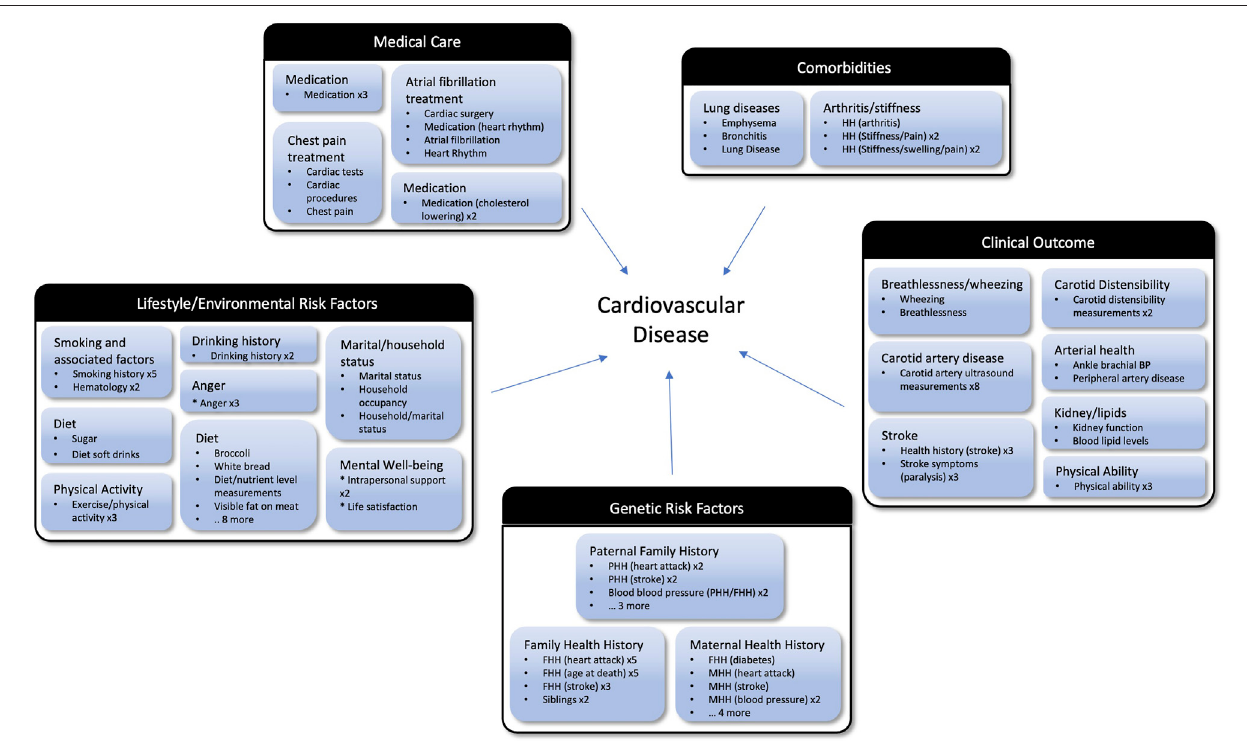
FIGURE 6 | Cluster groups organized into topics based on the goals of the ARIC study. The outer black and white boxes are topics (e.g., Clinical Outcome and Medical Care) and each topic contains multiple cluster groups (e.g., Stroke and Lung Diseases) which are the blue boxes. Listed under the manually assigned label for each cluster groups are bullets representing the clusters which are members of that group. If there are multiple clusters within a group with the same name, after the cluster name they have an “ x ” and the number of times that cluster appears. For example, Anger x3 means there are three clusters in that group with the name Anger. Abbreviations: MMH, Maternal Health History; PHH, Paternal Health History; MH, Medical